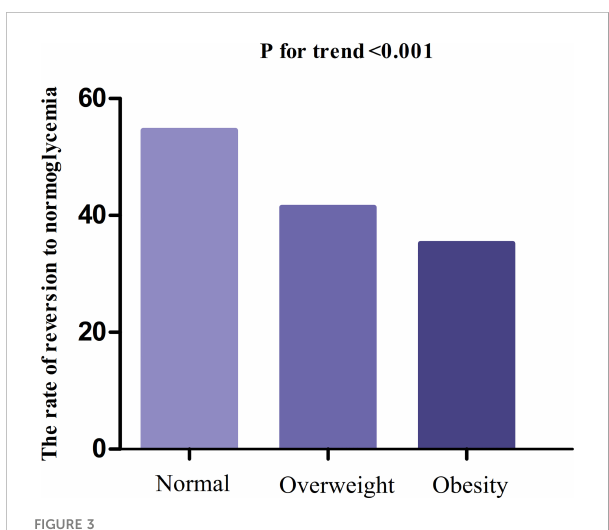
FIGURE 3 The rate of reversion to normoglycemia in people with IFG strati fi ed by BMI. Participants with higher BMI had a signi fi cantly lower reversal rate than those with a lower BMI (p<0.001 for trend).